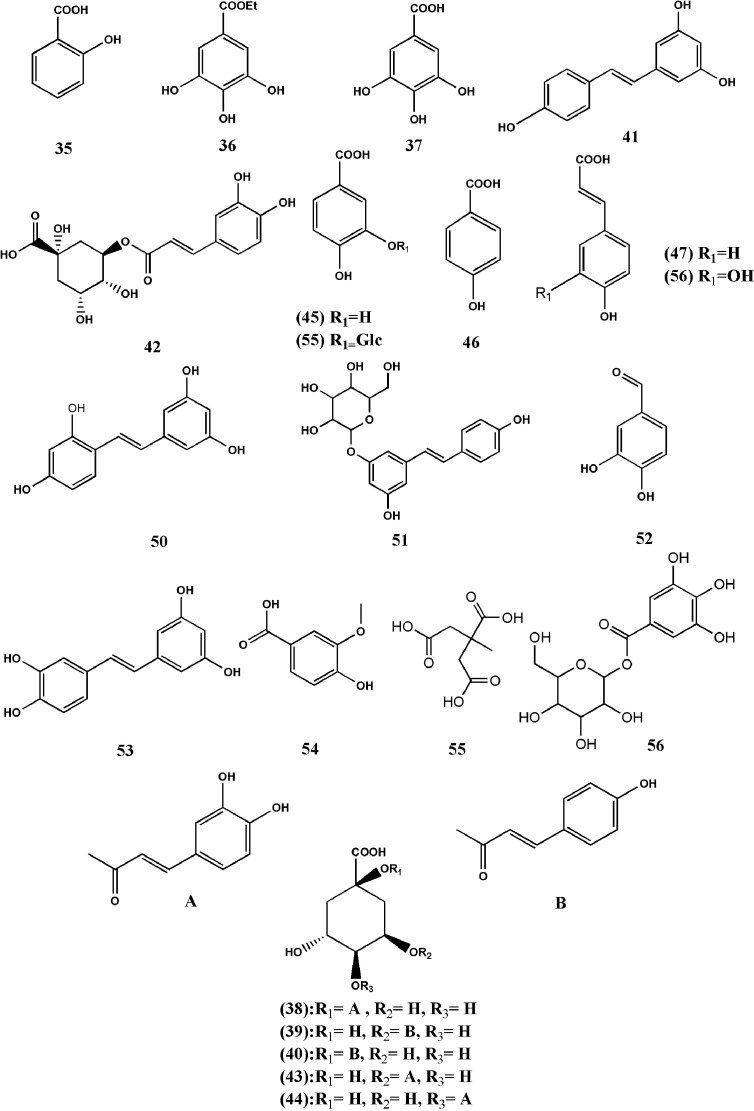
Structures of phenolic acids from Tetrastigma hemsleyanum Diels & Gilg.